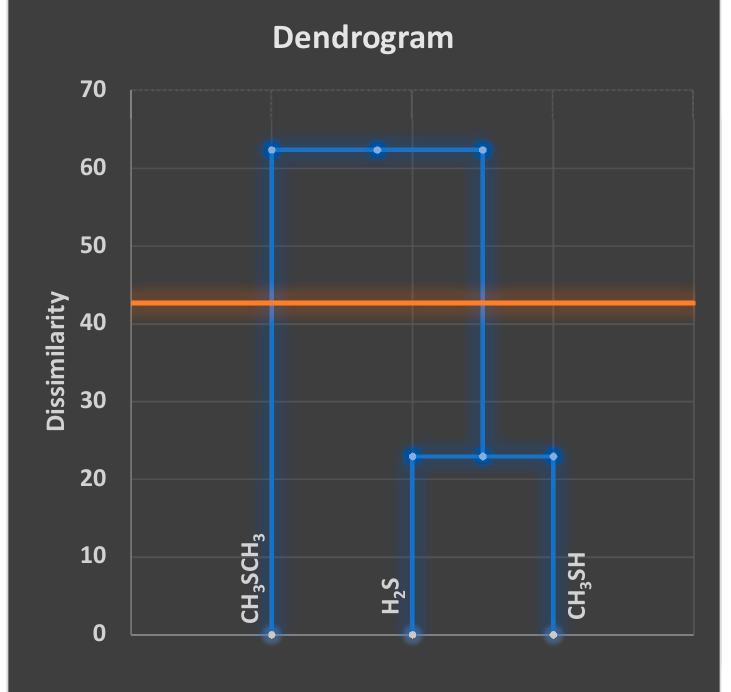
Figure 7. Agglomerative hierarchical clustering ( AHC) dendrogram diagram of the 0.00 h. time-point oral cavity VSC level dataset demonstrating a clear distinction of clusters consisting of (1) combined and strongly correlated H 2 S and CH 3 SH concentrations, and (2) (CH 3 ) 2 S concentration. The horizontal orange boundary shows the dissimilarity threshold limit for this model.